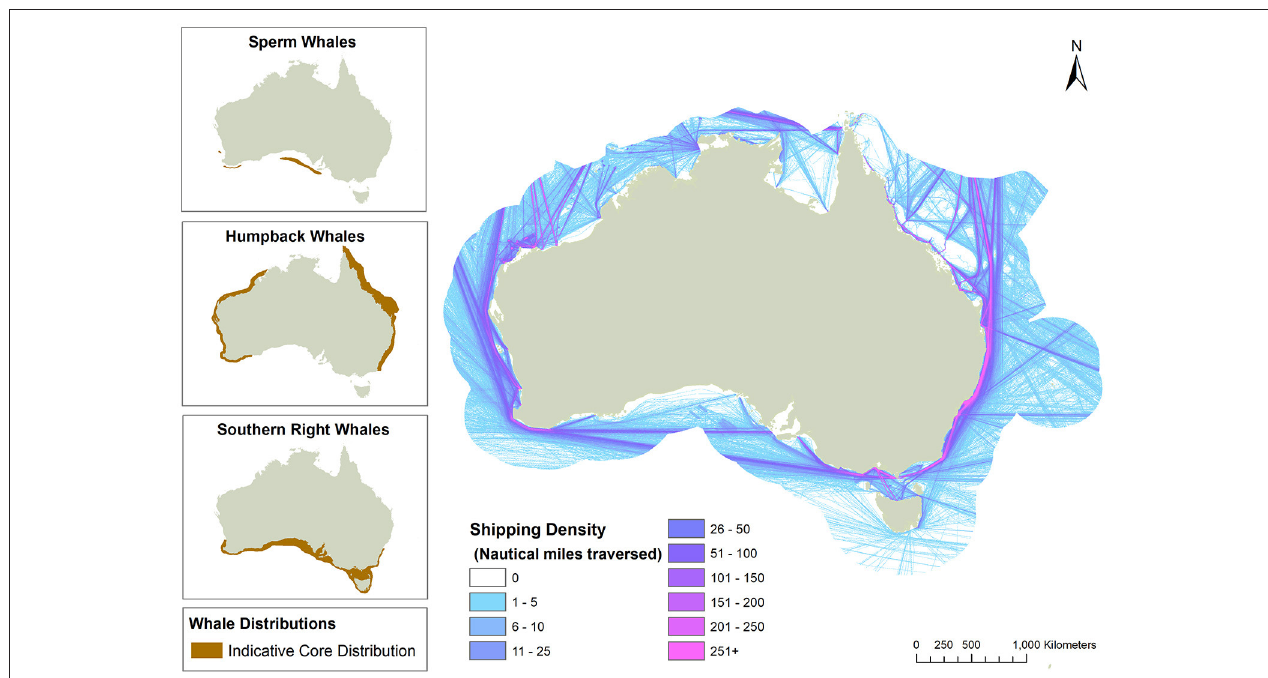
FIGURE 1 | Australian 2014 shipping ( > 24m length) density (nautical miles traveled in each 1 × 1 nautical mile grid cell) and humpback, southern right whale and sperm whale core locations in the Australian Economic Zone. Shipping based on AMSA AIS data. Whale distributions based on existing Department of Environment and Energy maps that are indicative only for general information based on 2011